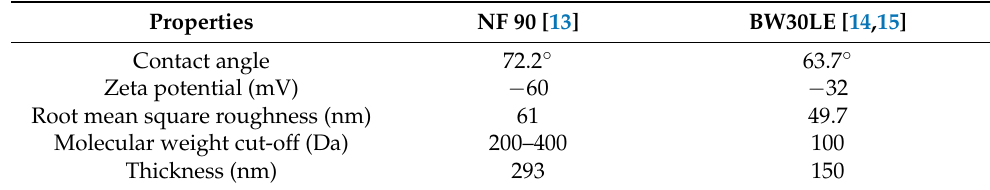
Table 2. Characteristics for the nanofiltration and reverse osmosis membrane used in the